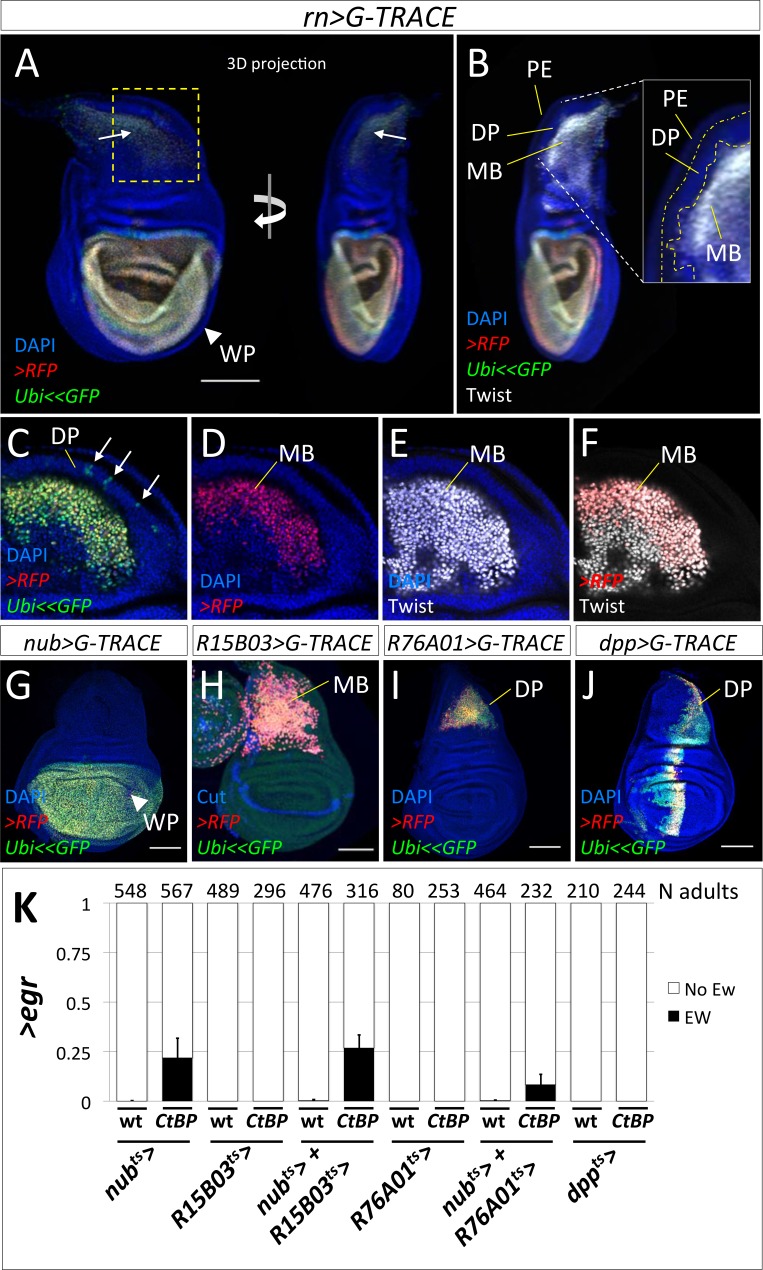
Expression of eiger in the wing pouch, but not in the myoblasts or notum epithelium, is sufficient to induce ectopic wings.(A, B) A 3D-projection of a late L3 wing disc of rn>G-TRACE, which shows current (UAS-RFPnls) and past (UAS-FLP, Ubi<stop<GFPnls) expression of rn-GAL4. There is strong rn> expression in the wing pouch (WP) and much weaker expression in a subset of the myoblasts (MB). (B) The same disc with MB marker Twist and a close-up to highlight the three cell layers in the notum: the peripodial epithelium (PE), the disc proper (DP) and the myoblasts (MB). (C–F) Close-up of the notum. (C) In addition to the MB, past expression (GFP) is detected in a few scattered cells in the DP of the notum (arrows). (D–F) Current expression (RFP) in the notum is limited to a subset of the MB, all of which express Twist. (G) nub>G-TRACE shows that current and past expression is mostly limited to the wing pouch (WP). (H) R15B03>G-TRACE shows expression is limited to the MB (anti-Cut identifies myoblasts and the stripe at the dorsoventral boundary of the DP). (I) R76A01>G-TRACE shows current and past expression is limited to the notum of the DP. (J) dpp>G-TRACE shows expression in the DP of the notum, the hinge, the WP and PE. (K) Frequency of EWs in adults following expression of >egr with the listed GAL4 drivers, in wild type or CtBPQ229*/+ genetic backgrounds. All cultures were shifted from 18°C to 30°C on day 7 AEL for 40 hr. Error bars show standard deviations.